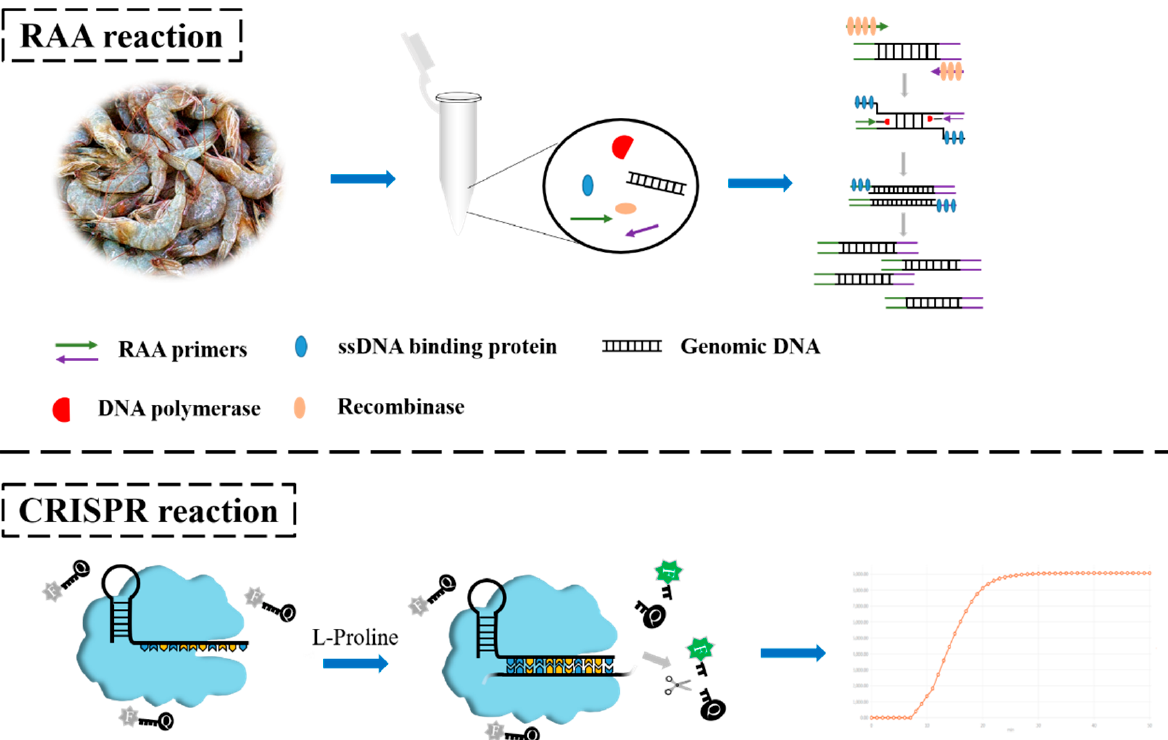
Figure 1. Schematic illustration of the principle of CE–RAA–CRISPR.